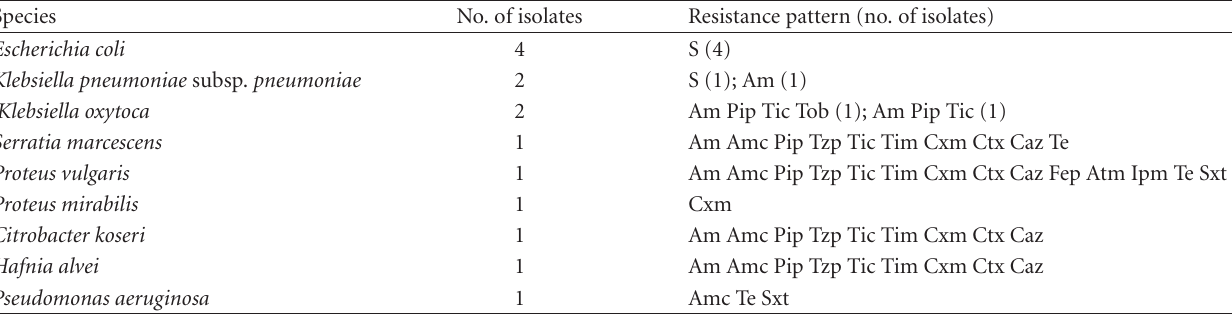
Table 2: Gram-negative rods isolated from upper respiratory tract from examined patients and their resistance patterns. Species No. of isolates Resistance pattern (no. of